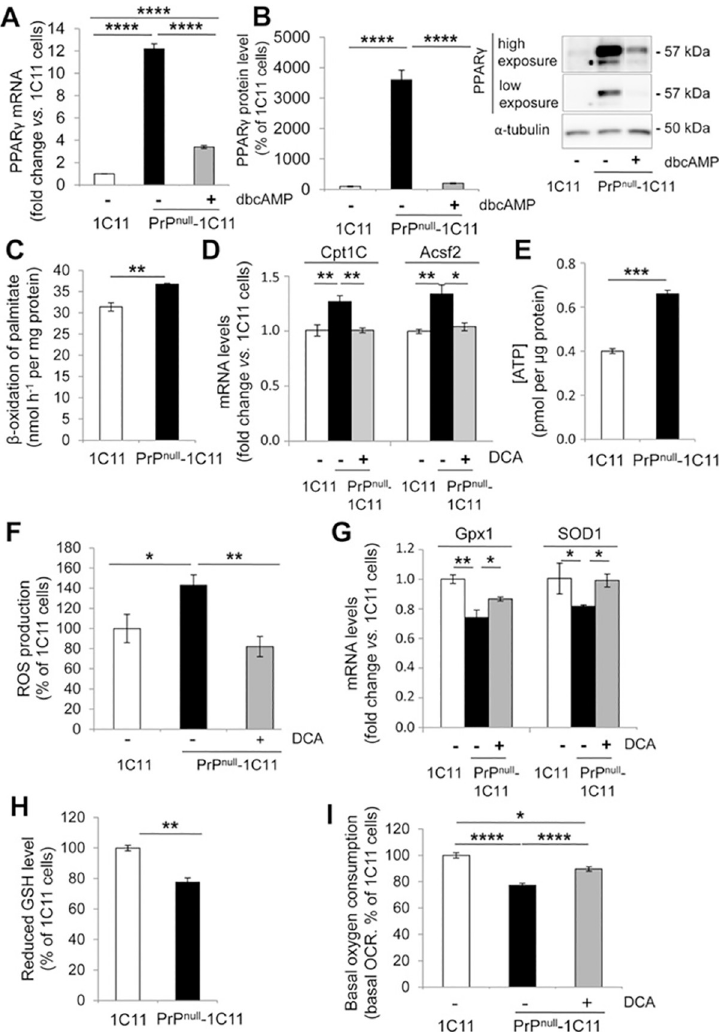
Fig 5. PDK4-dependent PDH inhibition provokes increases of the lipid handling and oxidative stress in PrP null - cells. ( A ) Relative mRNA levels of PPAR γ between 1C11, PrP null -1C11, and PrP null -1C11 cells treated for 24 h with dbcAMP (1 mM), grown in a medium containing 25 mM glucose, as assessed by RT-qPCR (n = 10). ( B ) Representative western blot and histogram quantifications for PPAR γ in 1C11 and PrP null -1C11 cells treated or not with dbcAMP. α -tubulin was used for normalization (n = 7). ( C ) Palmitate β -oxidation rate measured in 1C11 and PrP null -1C11 cells (n = 3). ( D ) Relative mRNA levels of Cpt1C and Acsf2 between 1C11 and PrP null -1C11 cells exposed or not to DCA (2 mM) for 6 h, as assessed by RT-qPCR (n = 6). ( E ) ATP levels in 1C11 and PrP null -1C11 cells measured by luminescence (n = 3). ( F ) ROS levels in 1C11 and PrP null -1C11 cells exposed or not to DCA (2 mM, 6h) measured by fluorescence (n = 6). ( G ) Relative mRNA levels of SOD1 and Gpx1 between 1C11 and PrP null -1C11 cells exposed or not to DCA (2 mM, 48h), as assessed by RT-qPCR (n = 3). ( H ) GSH levels in 1C11 and PrP null -1C11 cells (n = 6). ( I ) Basal OCR in 1C11 and PrP null -1C11 cells grown in 25 mM glucose in the presence or not of DCA (2 mM) for 48 h (n = 6). Data are the mean ± SEM. � denotes p < 0.05, �� p < 0.01, ��� p < 0.001, and ���� p <